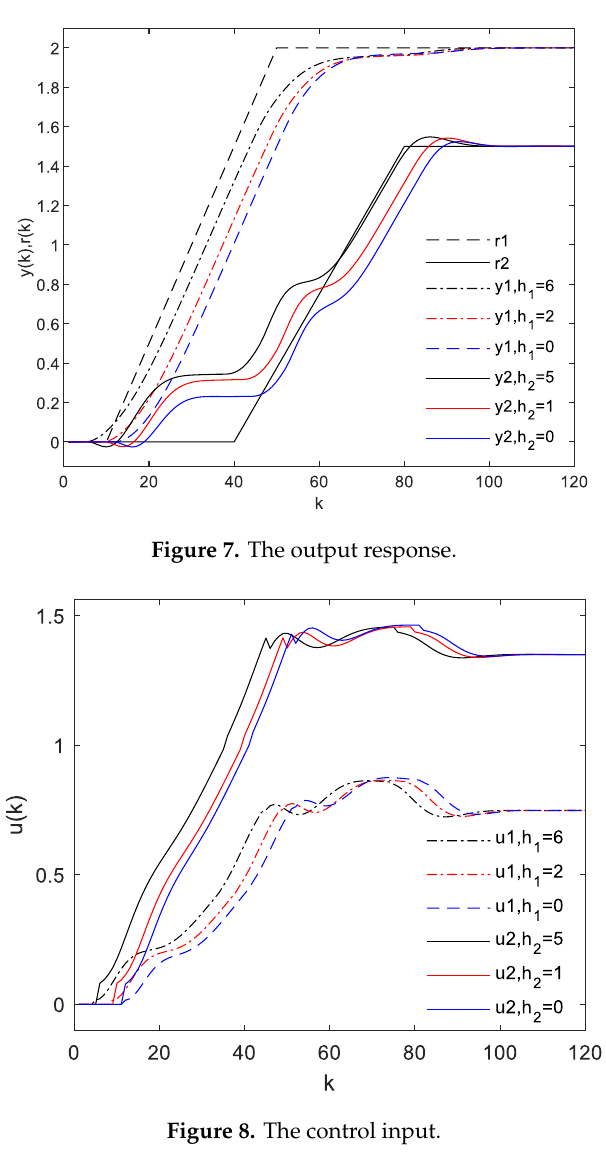
Figure 8. The control input.